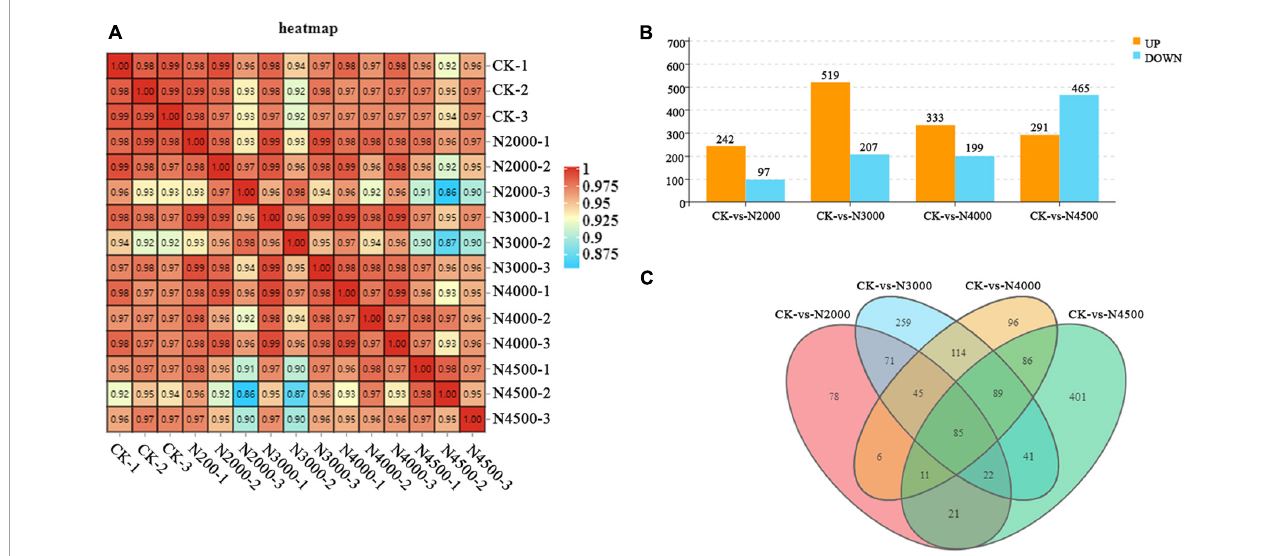
FIGURE2 Overall qualitative and quantitative analyses of the transcriptome data. (A) A heatmap with pearson correlation analysis of control and different treatment samples. (B) Histogram of DEGs of different samples. (C) Venn diagram of control and different samples.